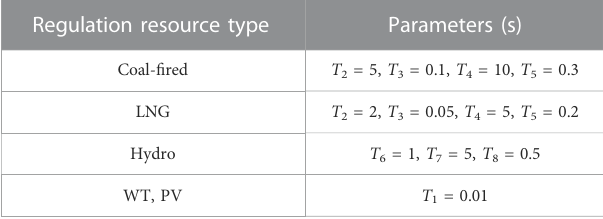
TABLE 3 Main parameters of the transfer function in the regulation resources.